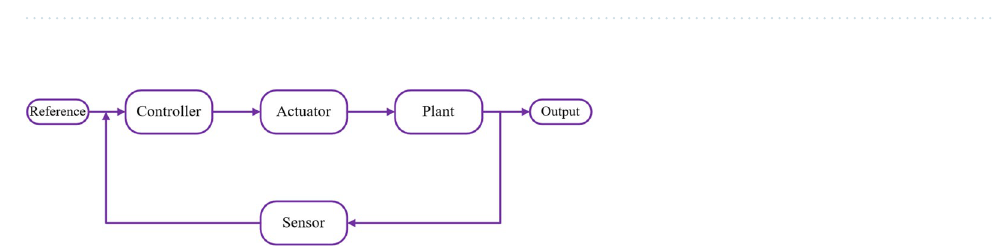
Figure 6. General open-loop control system.